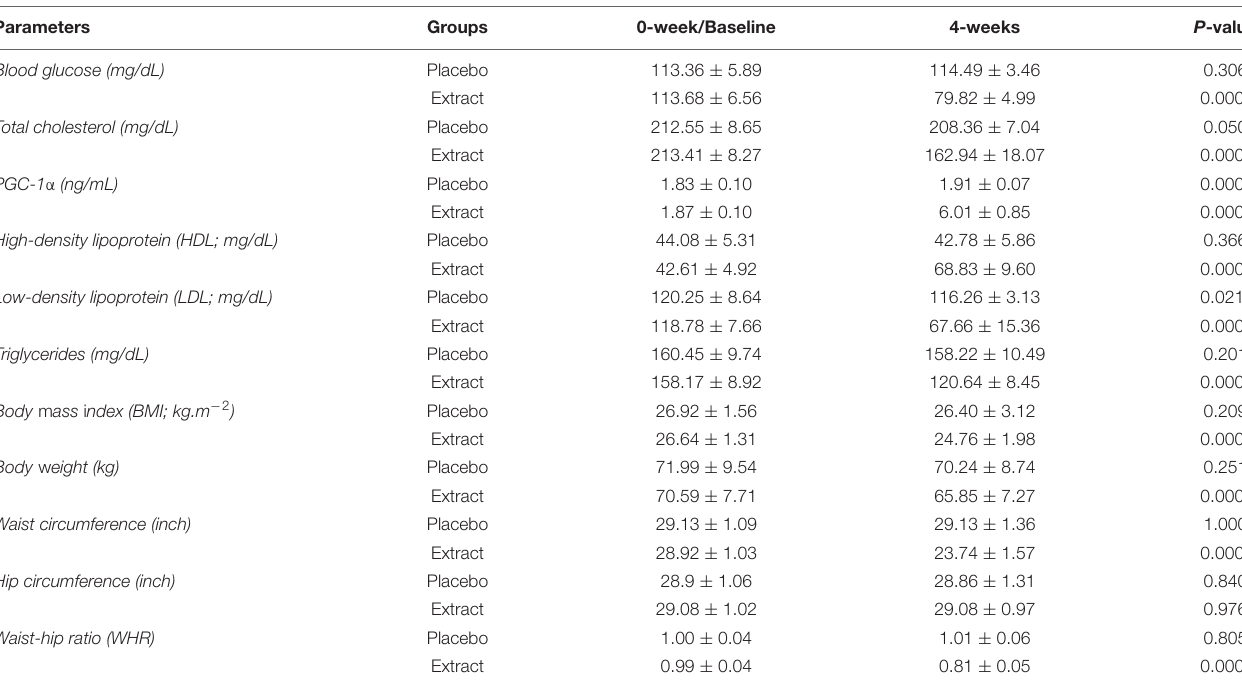
TABLE 6 | P-trend from 0-week to 4-week